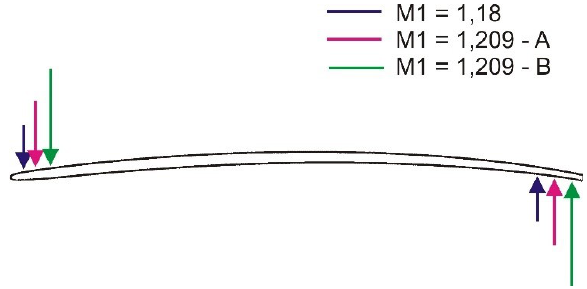
Figure 6. Scheme of torque load of the tip of the blade with non started supersonic flow